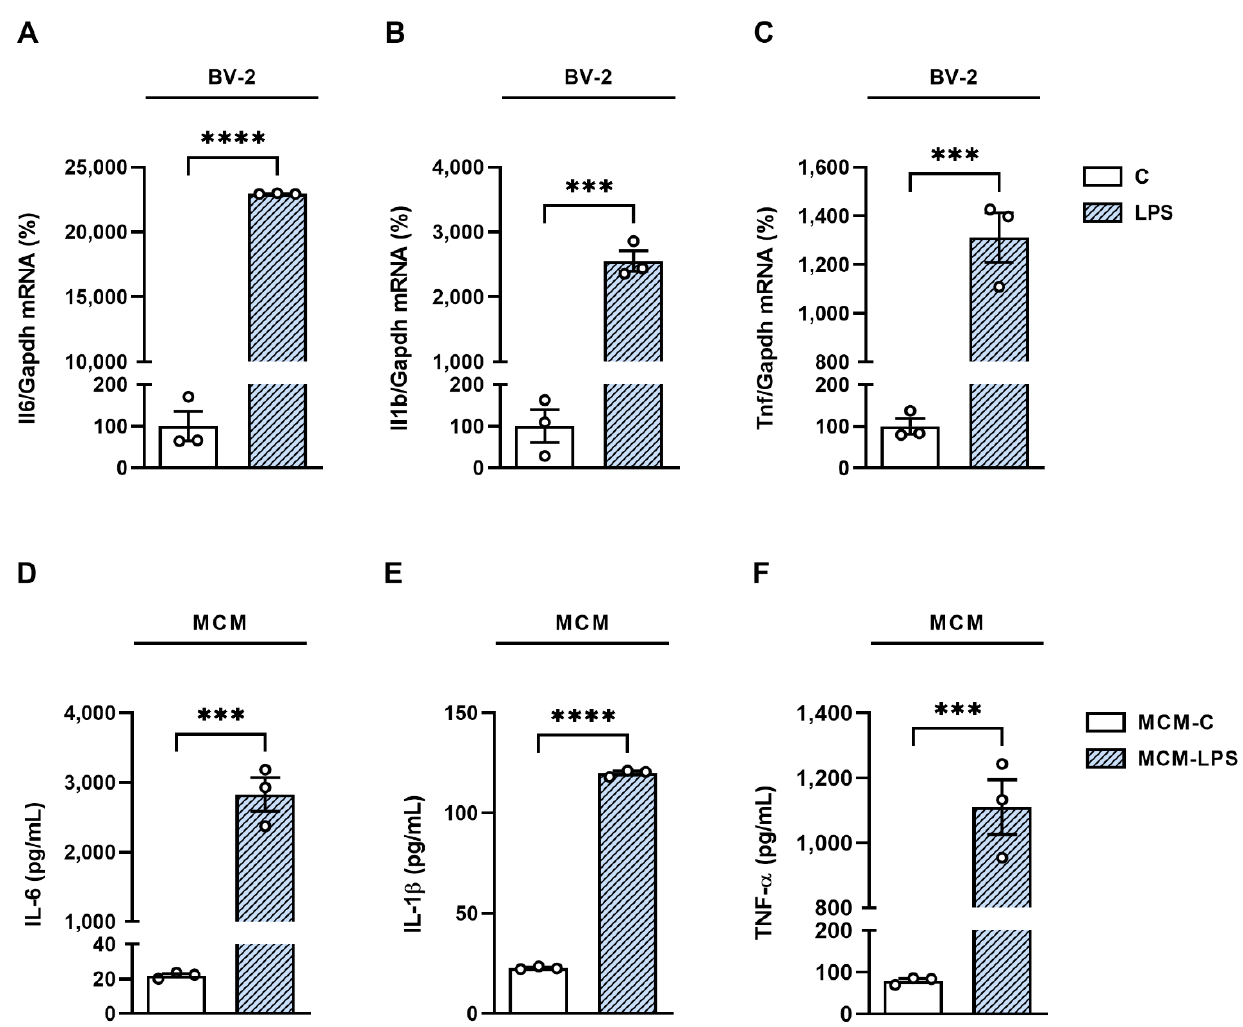
Figure 2. Activation of BV-2 cells with LPS induces the formation of pro-inflammatory microglial conditioned medium (MCM). BV-2 cells were treated with LPS (100 ng/mL) for 3 h and the expression of mRNA of genes encoding the pro-inflammatory cytokines ( A ) IL-6, ( B ) IL-1 β , and ( C ) TNF- α was evaluated by RTq-PCR. After LPS treatment, the cells were washed and kept in fresh culture medium for 16 h. The supernatant obtained from BV-2 cells previously treated with LPS (MCM-LPS) or maintained only in culture medium (MCM-C) was collected and the presence of the pro-inflammatory cytokines ( D ) IL-6, ( E ) 1L-1 β , and ( F ) TNF- α was quantified by the ELISA method. *** p < 0.001, **** p < 0.0001, n = 3.